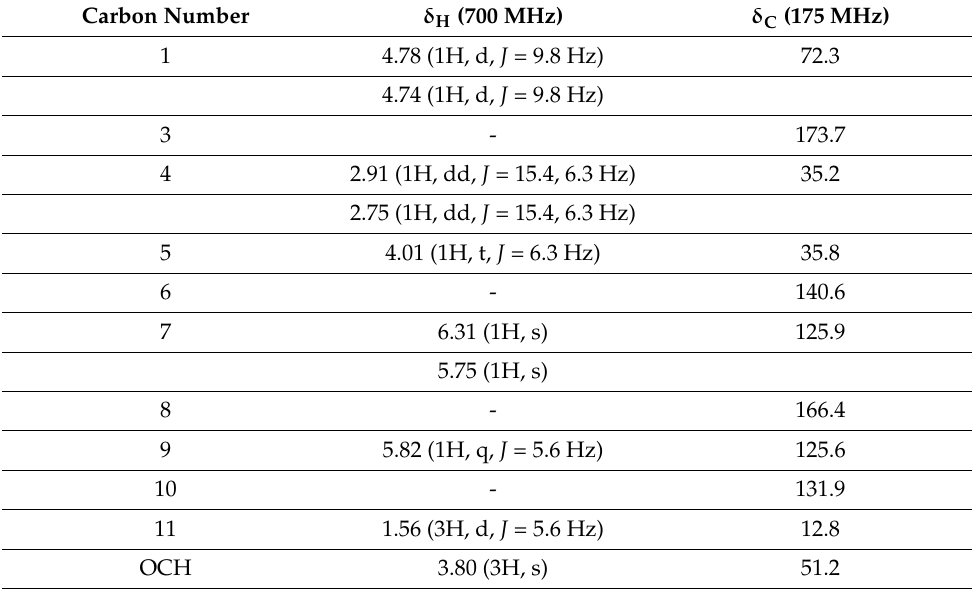
Table 1. NMR spectroscopic data for compound 1 (methanol- d 4